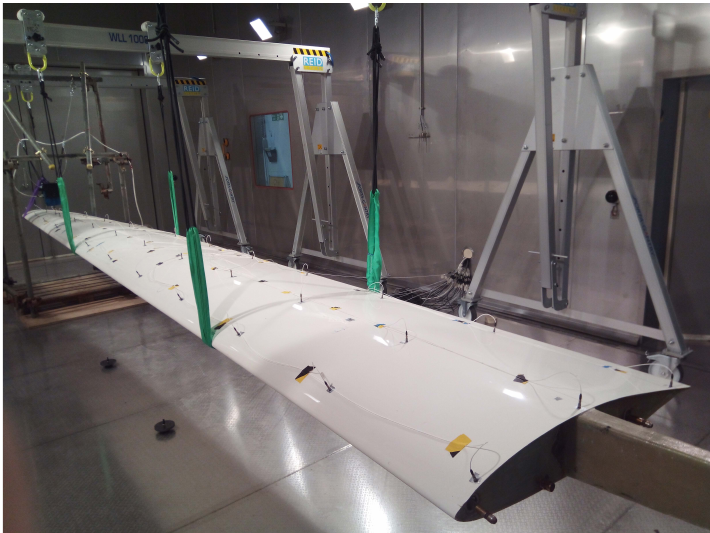
Figure 1. A composite wing structure mounted in a free-free configuration. A candidate set of 36 accelerometers are mounted to its upper